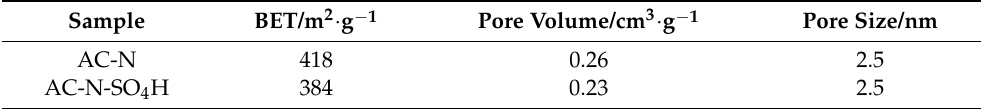
Figure 4. Pore size distribution for AC-N and AC-N-SO 4 H. Table 1. BET surface area of AC-N and AC-N-SO 4 H.